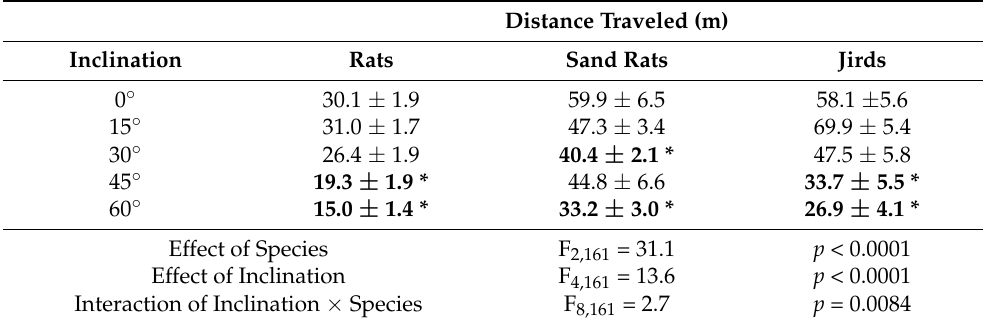
Table 1. Mean ( ± SEM) of the total distance (m) traveled by each species in each inclination. Results of a two-way ANOVA are depicted at the bottom of the table. In each species, a significant difference in each inclination, as revealed in a post-hoc comparison to 0 ◦ inclination by Dunnet test is depicted by * and bold font. Note: in the rats tested at 60 ◦ , four rats did not move at all after being introduced into the apparatus, and were therefore removed from further analyses.